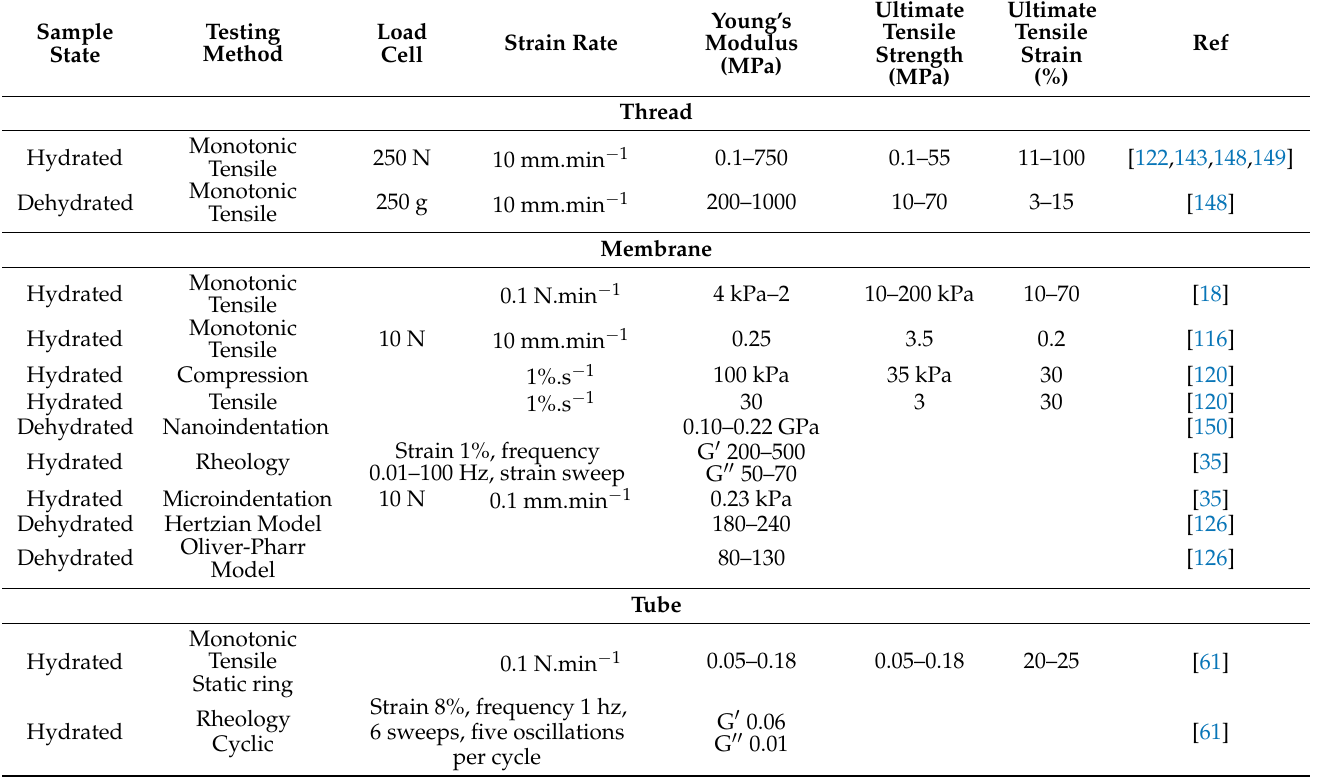
Table 3. Summary of the mechanical properties of electro-compacted collagen